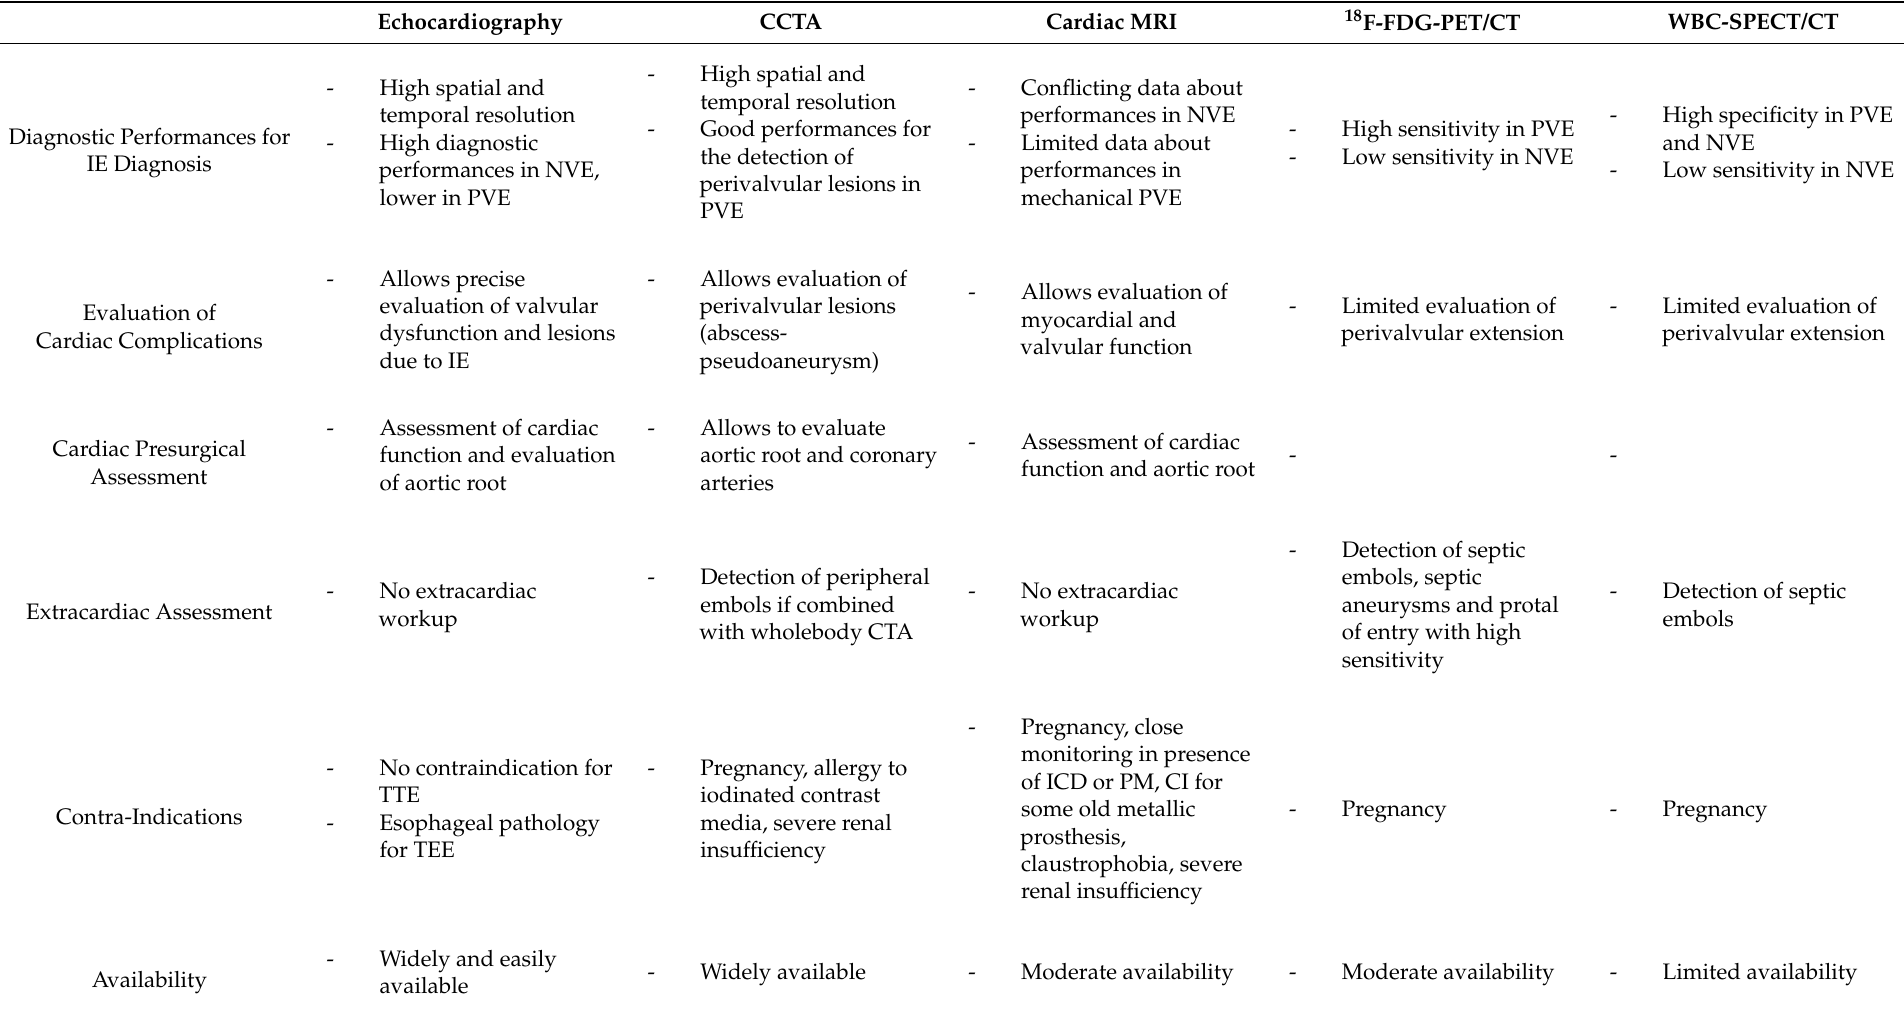
Table 5. Main advantages/limitations of nuclear/morphological techniques for the diagnosis of